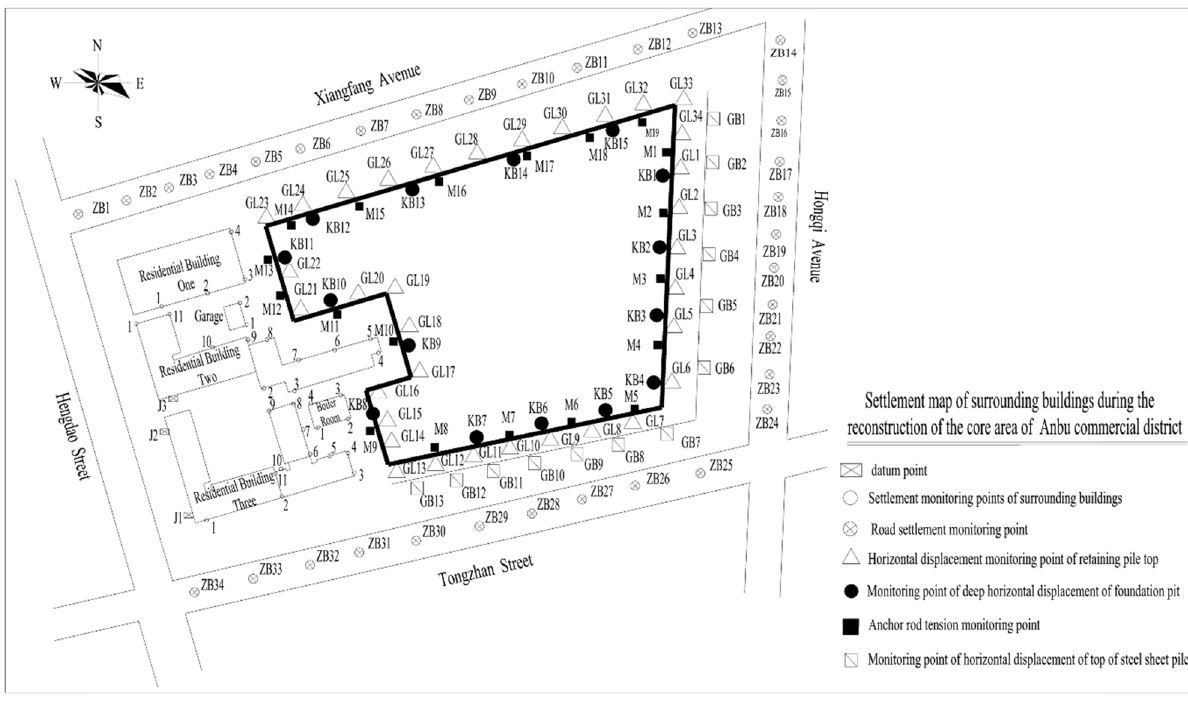
Figure 2: Layout of the monitoring points.